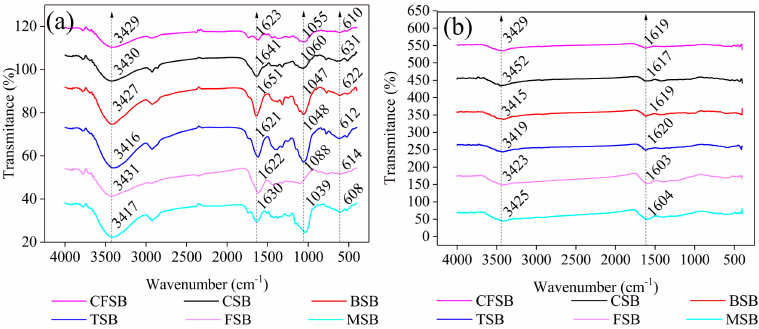
Figure 2. FTIR spectra of the six di ff erent biochars ( a ) before and ( b ) after adsorption of